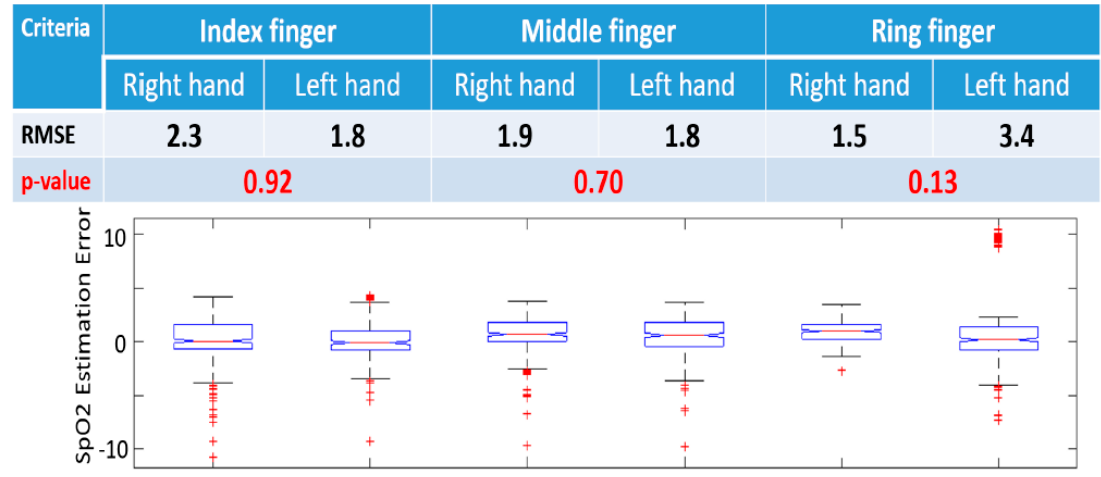
Figure 6. SpO2 model validation on different fingers (index, middle, and ring fingers), indicating that there is no significant difference among these fingers, and that the index and middle fingers are more appropriate for SpO2 monitoring because of lower RMSE. RMSE: Root mean square error (%), p -value is calculated using Wilcoxon signed-rank test. Bar graphs represent 10, 25, 50, 75, and 90 percentiles of SpO2 estimation error.